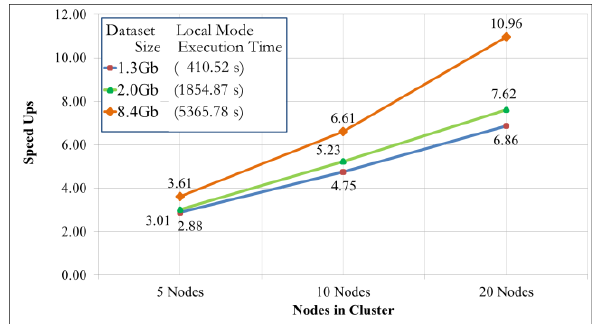
Figure 7. Speedups for the K-Means distributed clustering process.